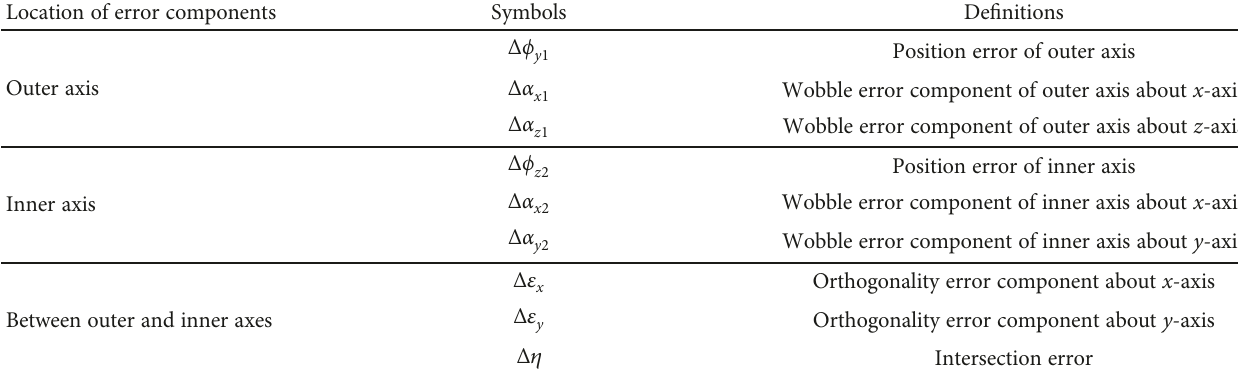
Table 2: Error components of a two-axis turntable system.